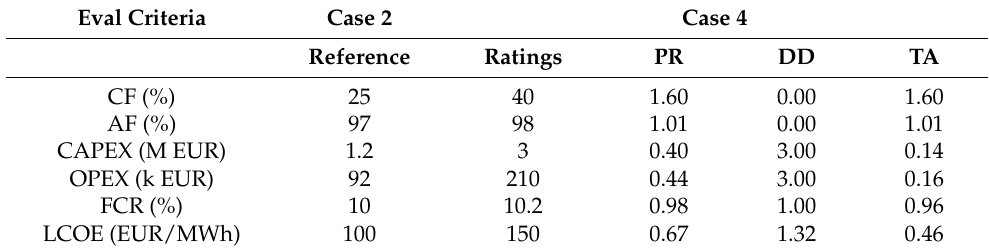
Table 13. TA for the utility-scale generation market.